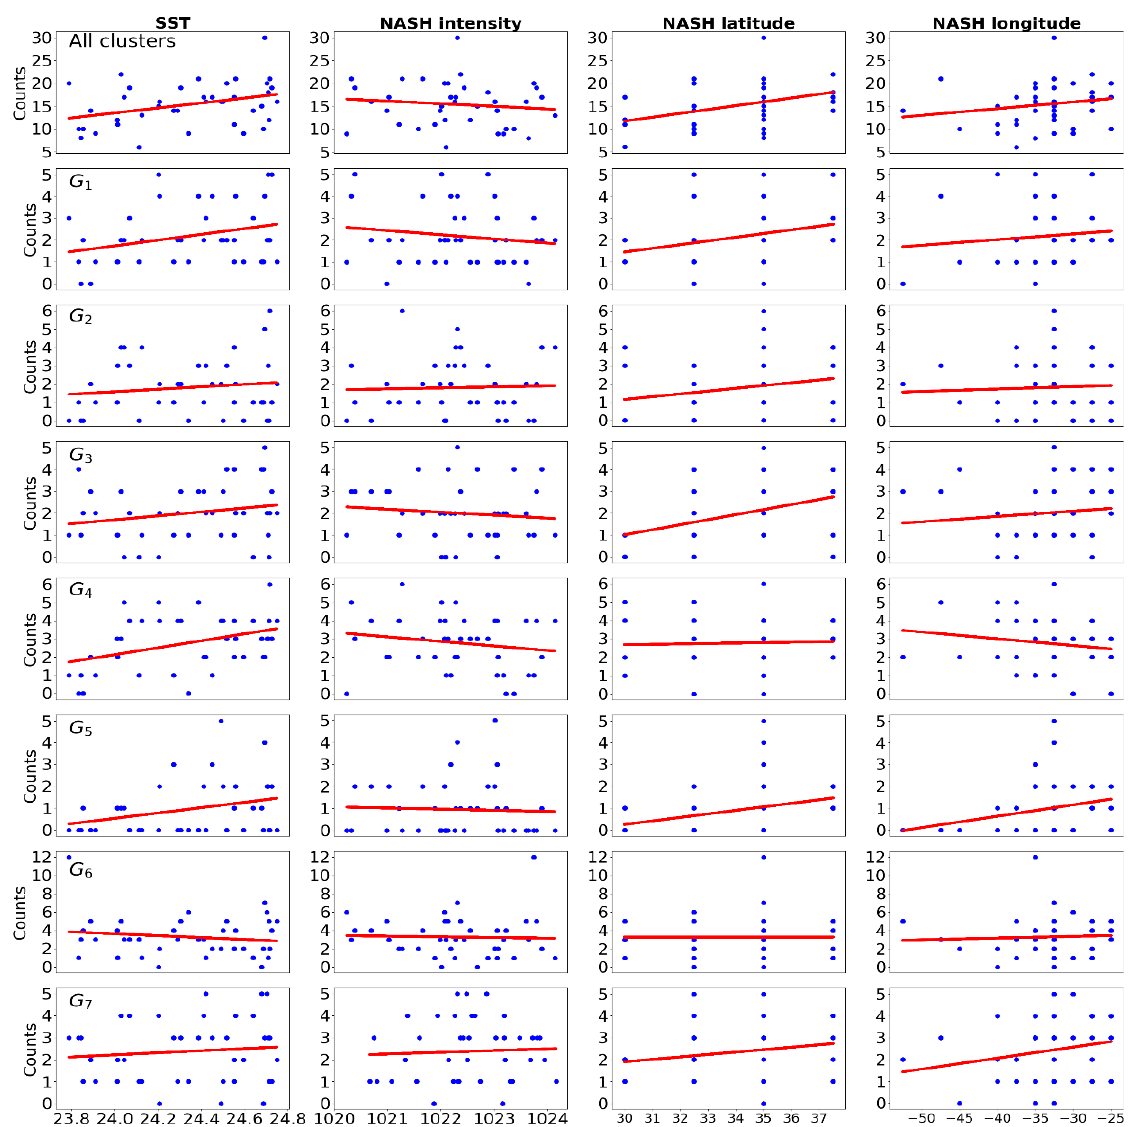
Figure 4. Frequency of TC genesis adjusted from the generalized least squares (GLS) linear regression model using the SST, NASH intensity, and NASH position as single covariate. “All clusters” represents the whole basin and G N (N = 1, 2, 3, 4, 5, 6, 7) represents each genesis cluster.